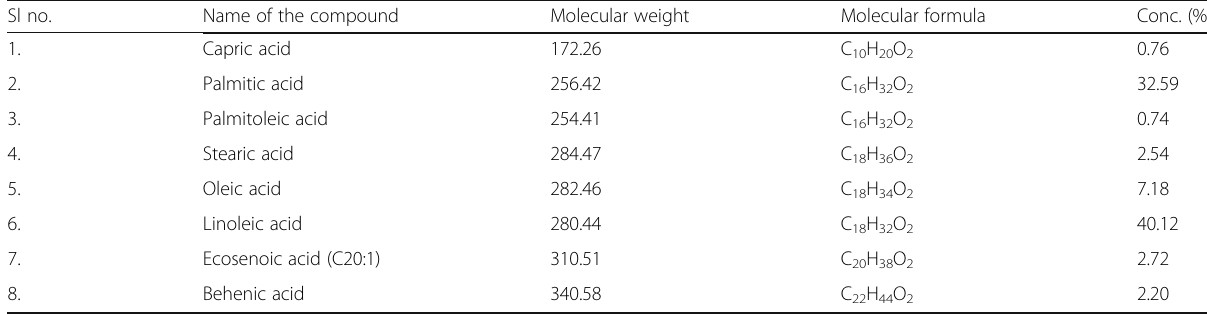
Table 3 GC-MS analysis of fatty acids of stems of Cassia sophera Linn Sl